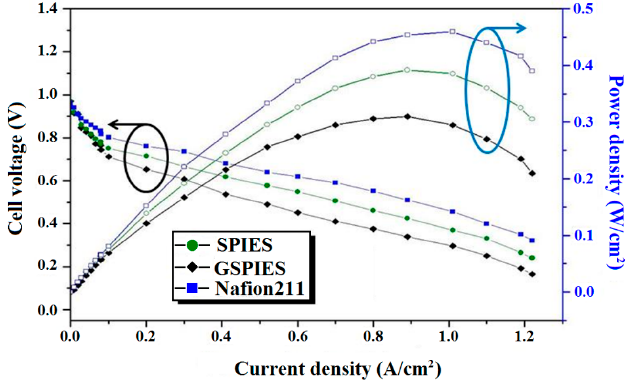
Figure 8. Cell performance of the membranes.